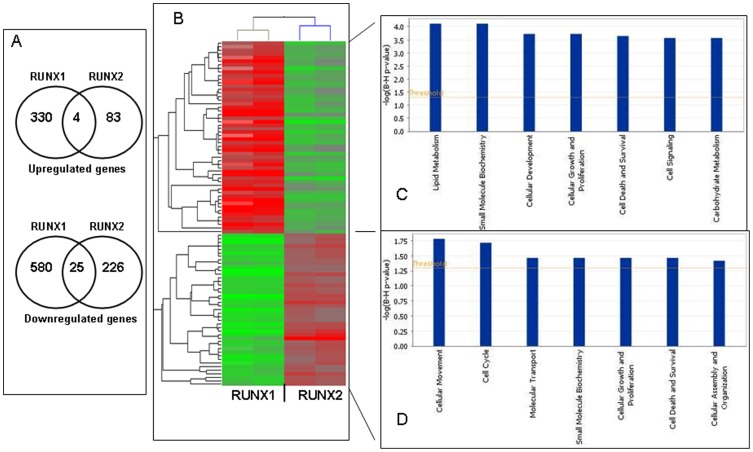
Comparison of common and distinct gene expressions across the various differentially-expressed gene groups upon RUNX1 and RUNX2 knockdown in SKOV3 cells.A. Venn diagram analyses of the differentially expressed genes upon RUNX1 and RUNX2 knockdown in SKOV3 cells. B. Hierarchical clustering based on the 95-genes list (2-fold difference in gene expression; p-value cutoff of 0.05) that discriminates differentially-expressed genes in SKOV3 cells upon RUNX1 and RUNX2 knockdown. Red signifies up-regulation, and green signifies down-regulation. C. IPA functional pathway analyses of genes, differentially expressed in SKOV3 cells upon RUNX1 and RUNX2 knockdown, based on the 95-genes list generated upon the clustering analysis.